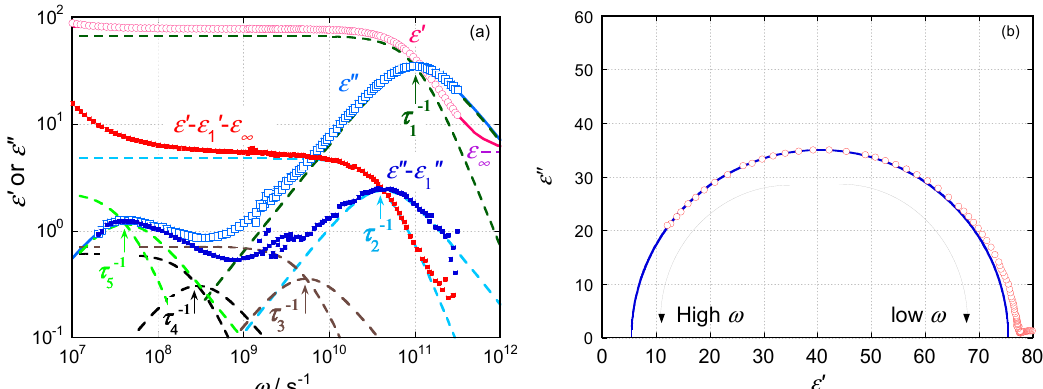
Figure 1. ( a ) Dielectric spectra ( ε ′ and ε ″ vs. ω ) for aqueous solution of HeC(1.3:90) at c = 0.23 M and 20 °C. Broken lines represent constituent relaxation modes from j = 1 to 5. The residuals of ε ′ – ε 1 ′ – ε∞ and ε ″ – ε 1 ″ are also plotted in the same figure with small closed symbols. ( b ) A Cole − Cole plot for the data shown in ( a ). A solid semicircle represents single Debye-type presentation for the major dielectric dispersion observed at ω ~ 10 11 s − 1 .